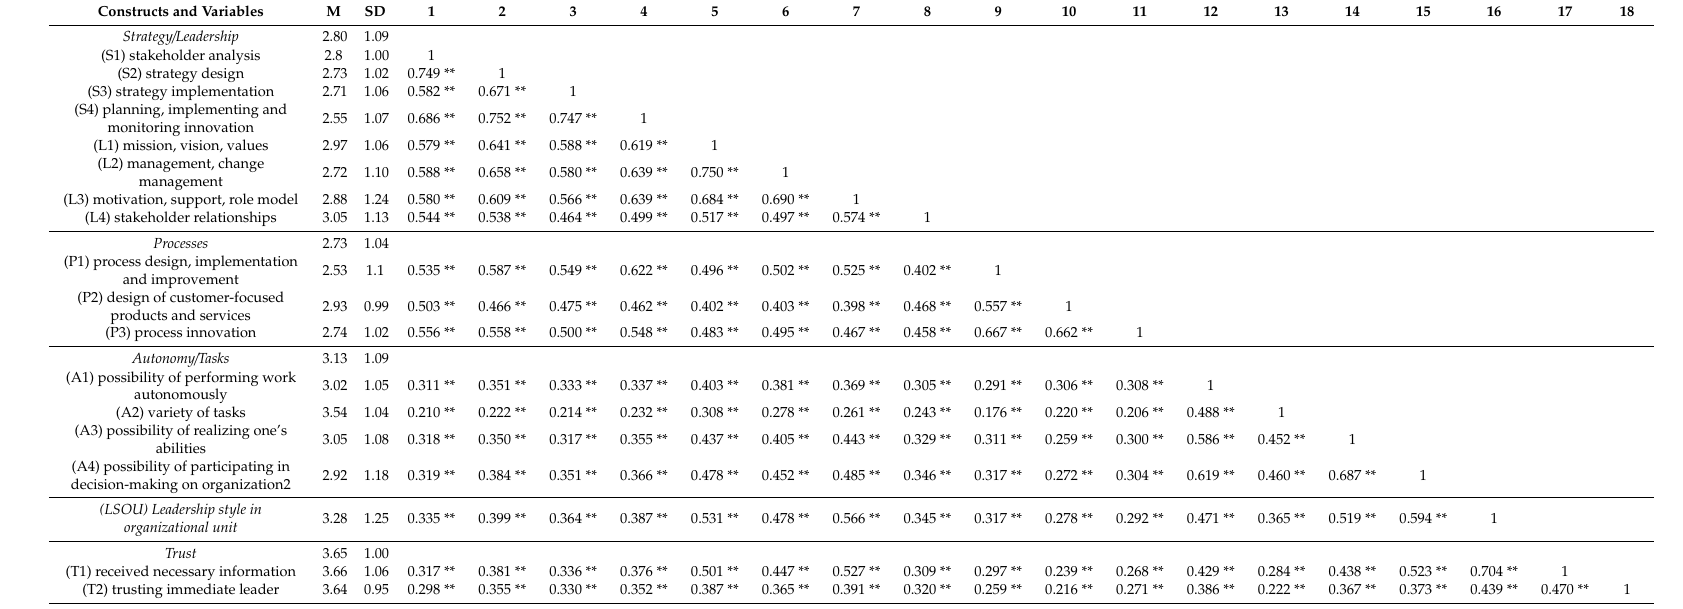
Table 1. Average values (M), standard deviations (SD) and correlations between